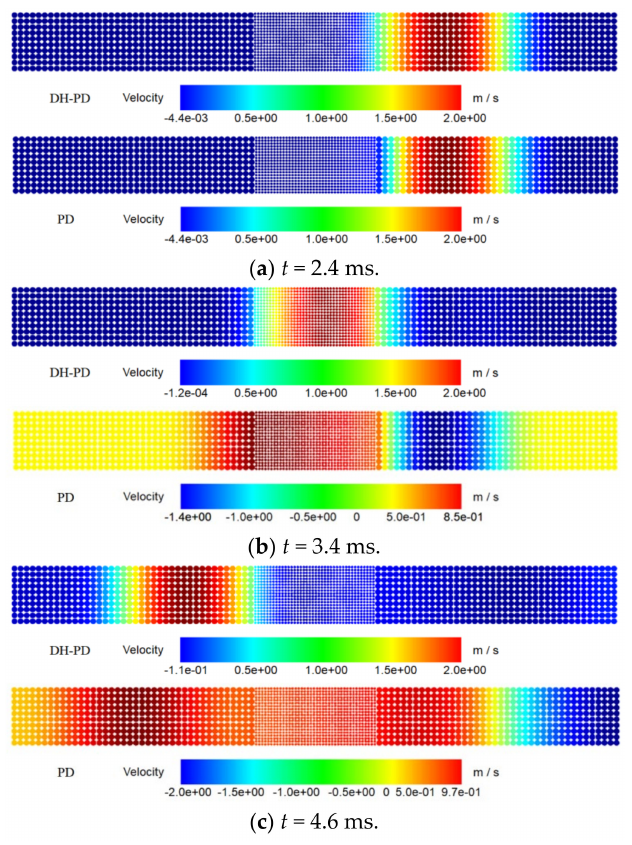
Figure 12. Velocity contour of wave passing through dense area.